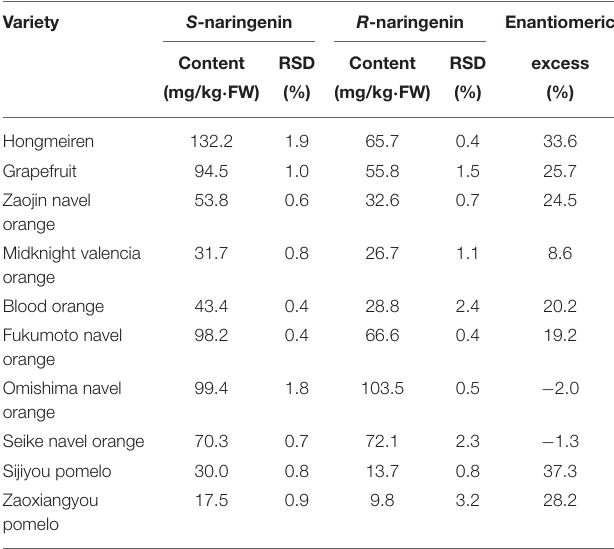
TABLE 3 | Application in determination of naringin enantiomers in different citrus pulp samples.